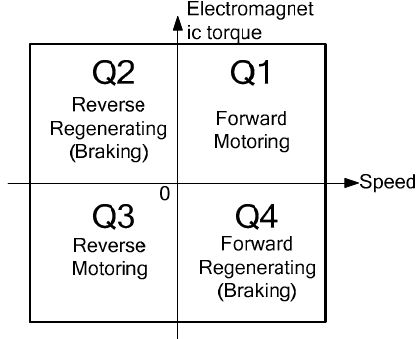
Figure 1. Quadrants of operation of a DC motor.